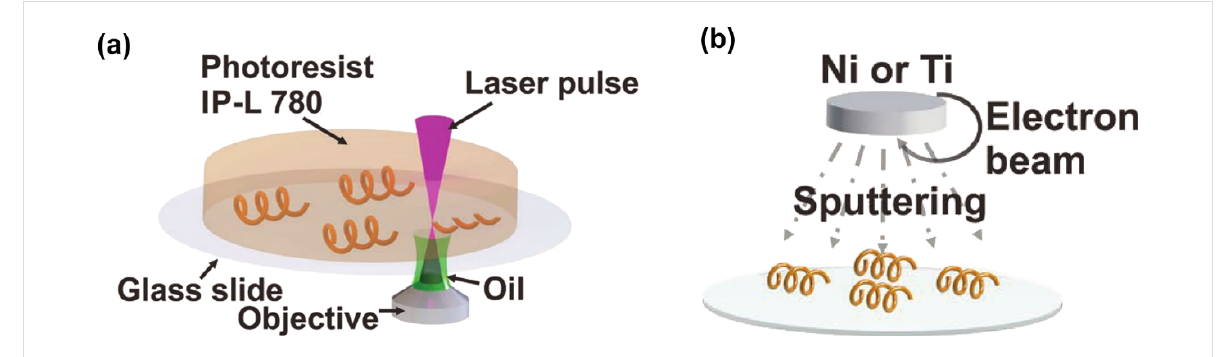
Figure 2: (a) A spiral swimmer with 2PP (also called artificial bacterial flagella (ABF)) and (b) coating the swimmers with nickel and titanium to make it magnetic and biocompatible. (a) and (b) adapted from [83], X. Wang et al., “MOFBOTS: Metal-Organic ‐ Framework ‐ Based Biomedical Microrobots”, Adv. Mater., with permission from John Wiley and Sons. Copyright © 2019 WILEY-VCH Verlag GmbH & Co. KGaA, Weinheim. This content is not subject to CC BY